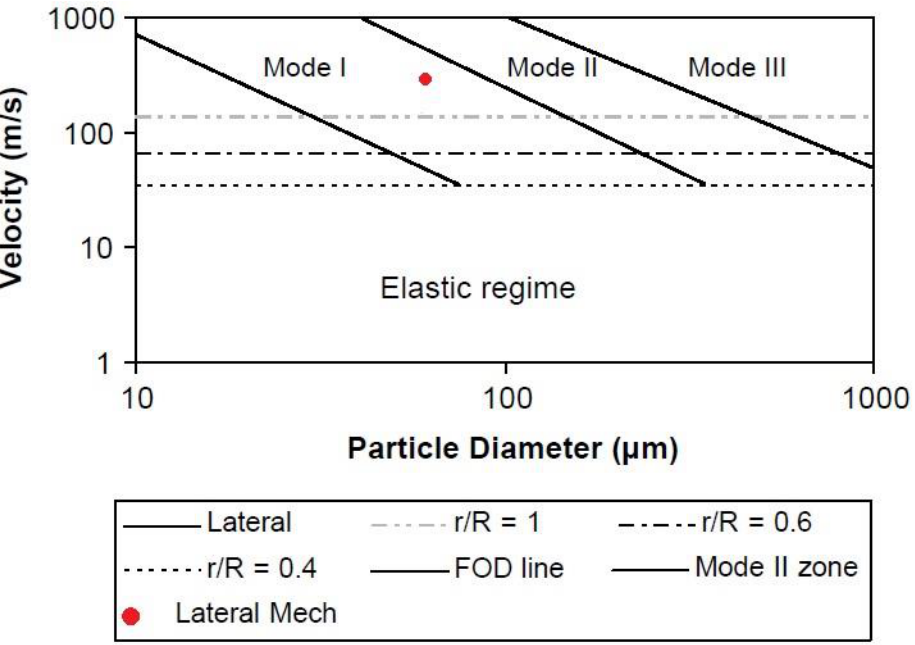
Figure 2. Erosion map for EB-PVD TBCs eroded with silica [12] in which the red spot marks the case for erodent with impact velocity 300 m/s and average diameter 60 μm .